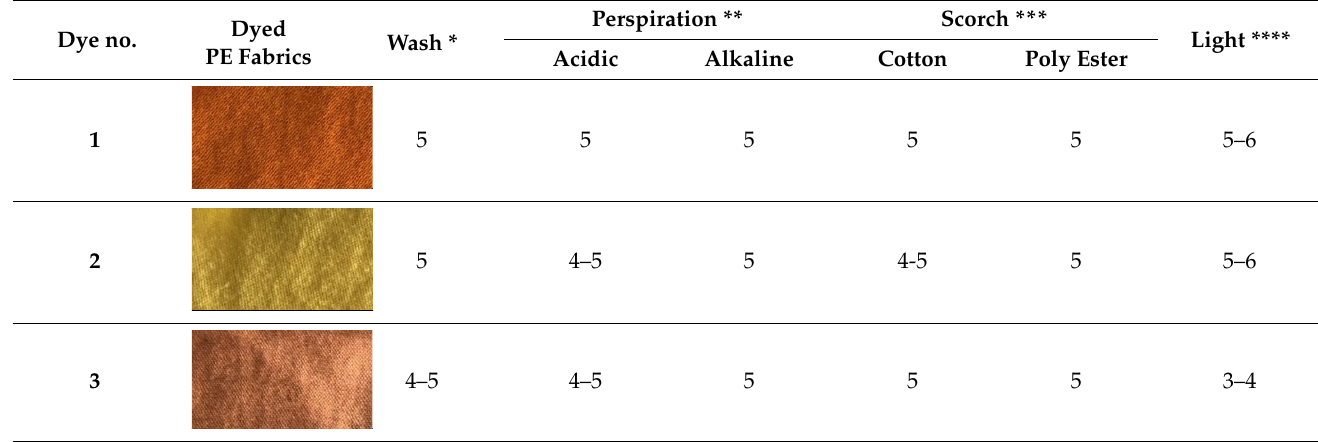
Table 3. Fastness properties of selected disperse azo dyes 1 – 4 , 6 , and 8 on polyester fabrics. Dye no. Dye